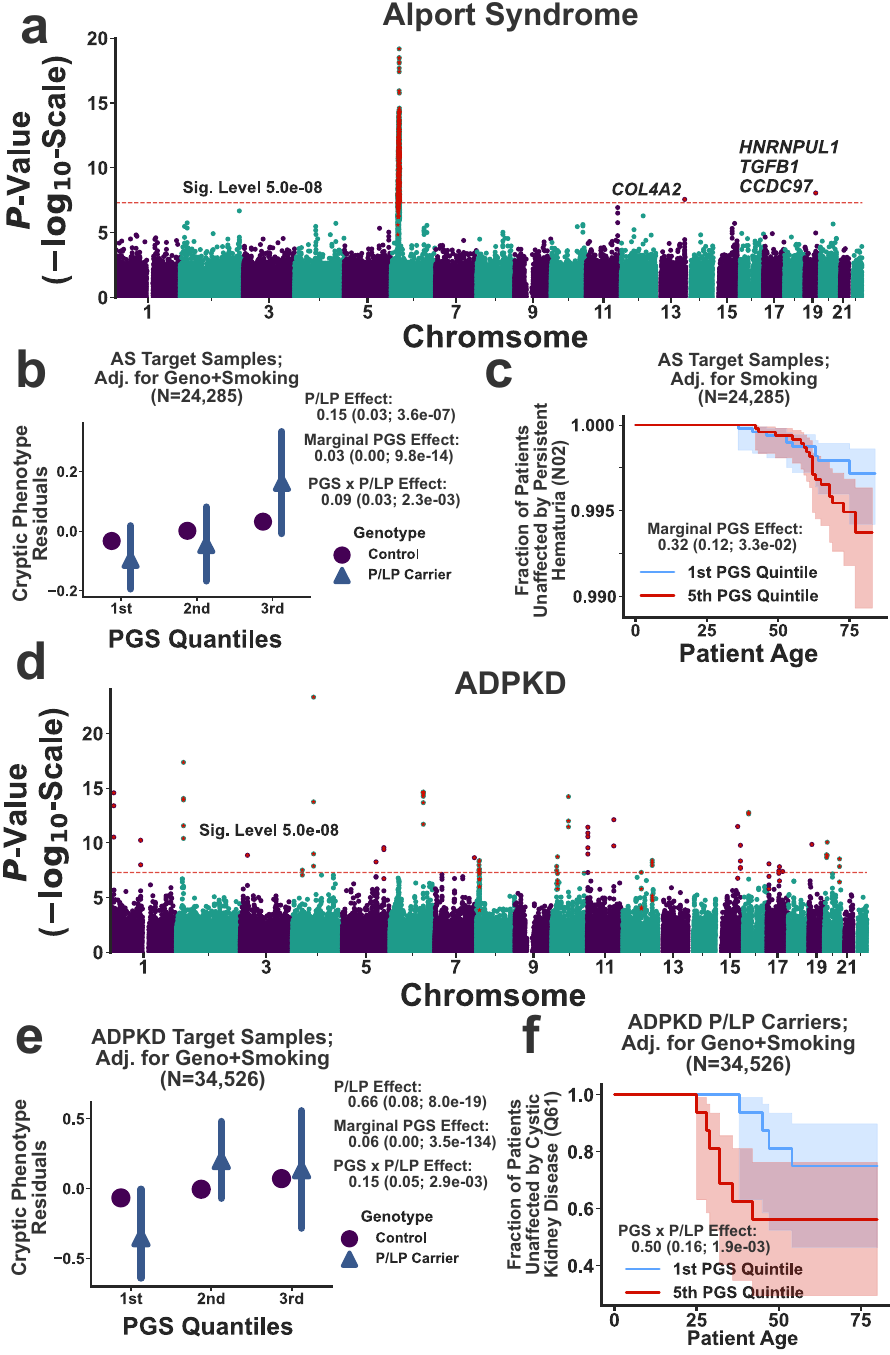
Cystic kidney disease onset (UKBB Data Field: 132533) was modeled as a function of both P/LP carrier status and polygenic load. As expected, ADPKD P/LP carriers were at high risk for early-onset cystic kidney disease (Cox proportional-hazards regression model; β P/LP = 3.73 ± 0.29; P -value = 3 : 2 ´ 10 (cid:1) 36 ), consistent with the known pathophysiology of the disorder. Interestingly, there was a signi fi cant interaction effect between the cryptic phenotype PGS and P/LP carrier status ( β PGSxP/LP = 0.50 ± 0.16; P -value = 0.002; see Fig. 6f), consistent with a model in which polygenic load modulates ADPKD severity. Because ESRD is the downstream effect of severe cystic kidney disease, we used